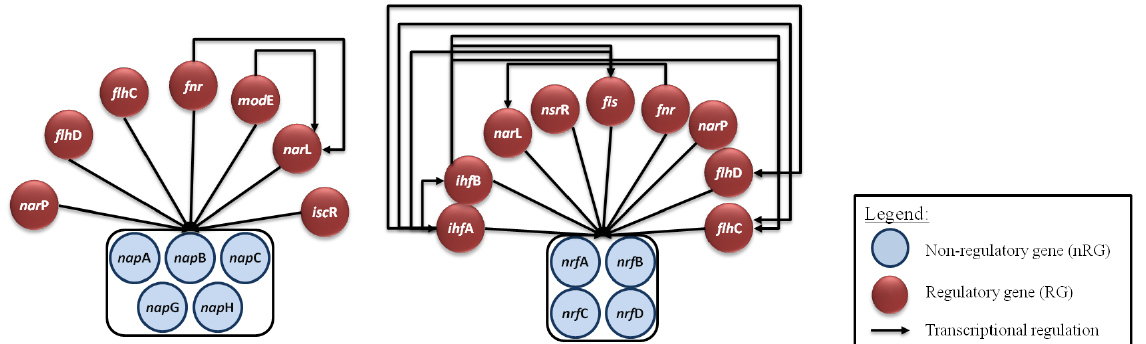
Figure 5: Examples of the long-term regulation affecting the “Nitrogen Metabolism”. The enzy- matic complexes nitrate and nitrite reductases encoded by the nap ABCGH and nrf ABCD operons, respectively, are exclusively controlled by the activity of transcription factors or regulatory genes